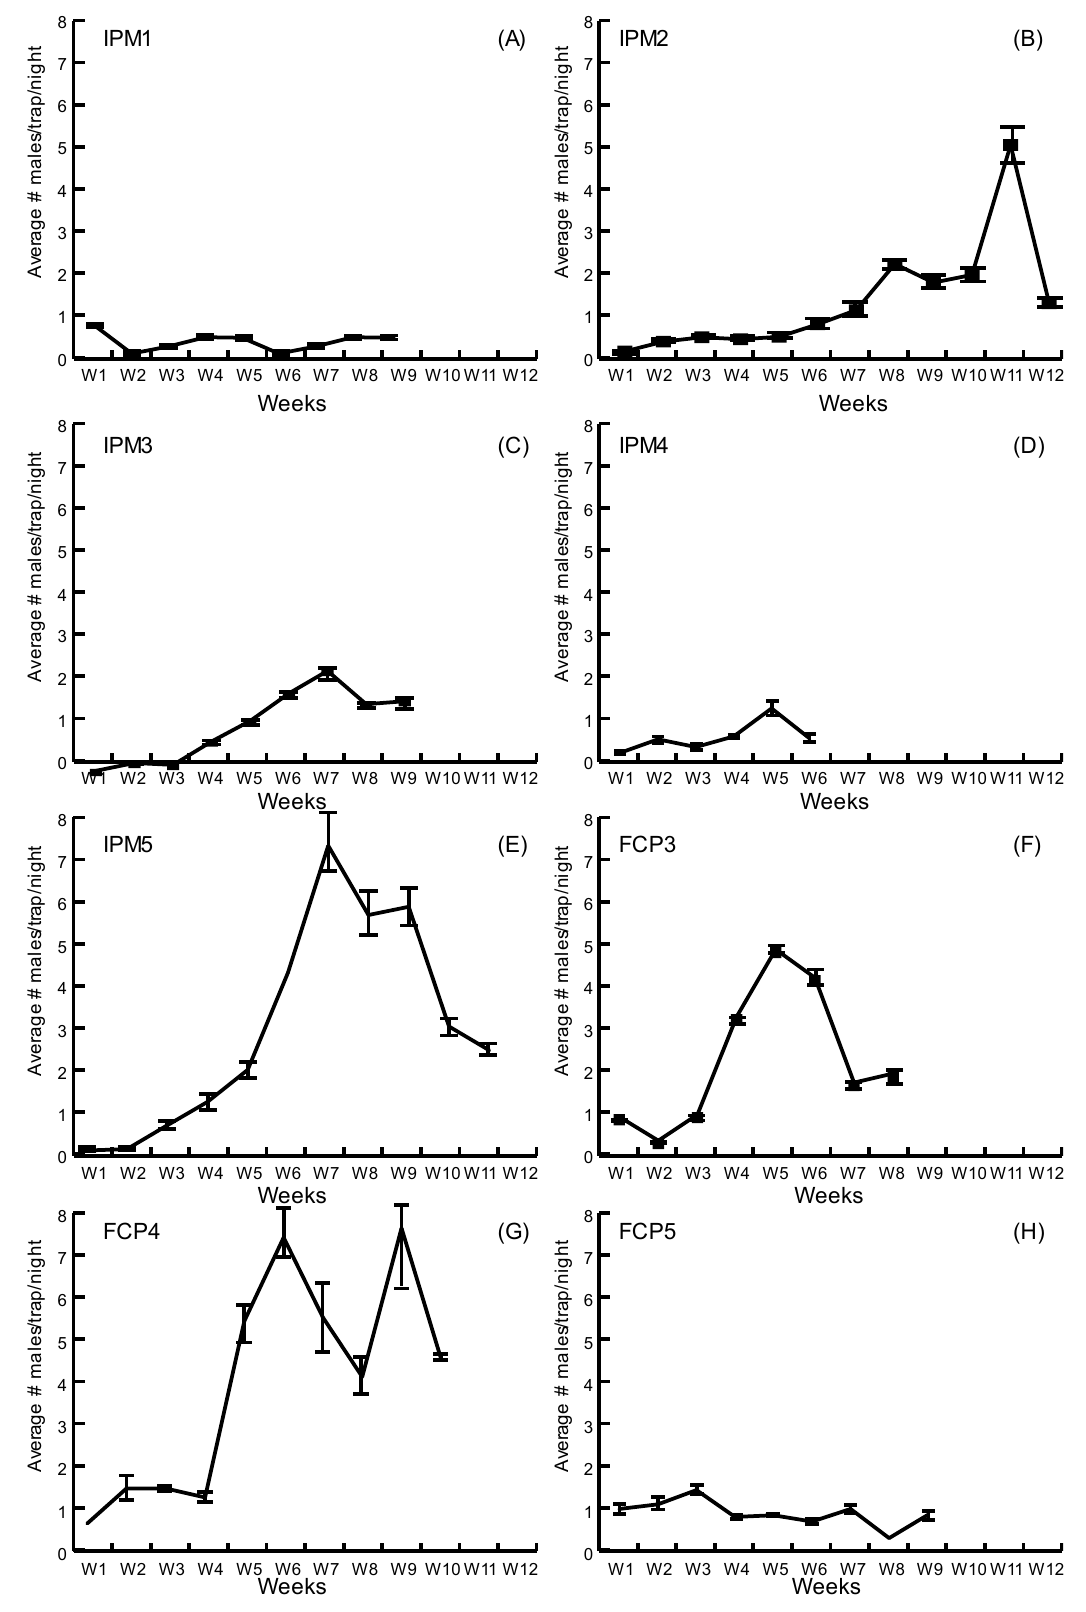
Figure 1. Average DBM male captures in IPM plots ( A – E ) and FCP plots ( F – H ) in Costa Rica. Standard error bars are shown for each evaluation.